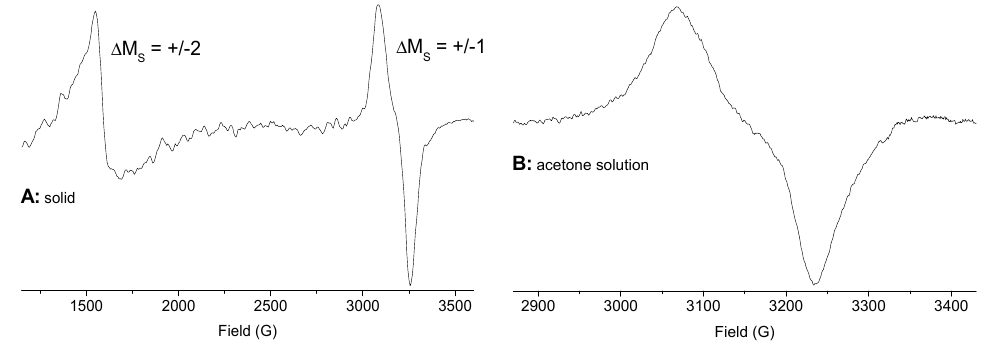
Figure 7. X-band EPR spectra of [{Cu(pydic(IPh) 2 )Cl} 2 (µ-Cl) 2 ] at 298 K. ( A ) in the solid. ( B ) in acetone solution.